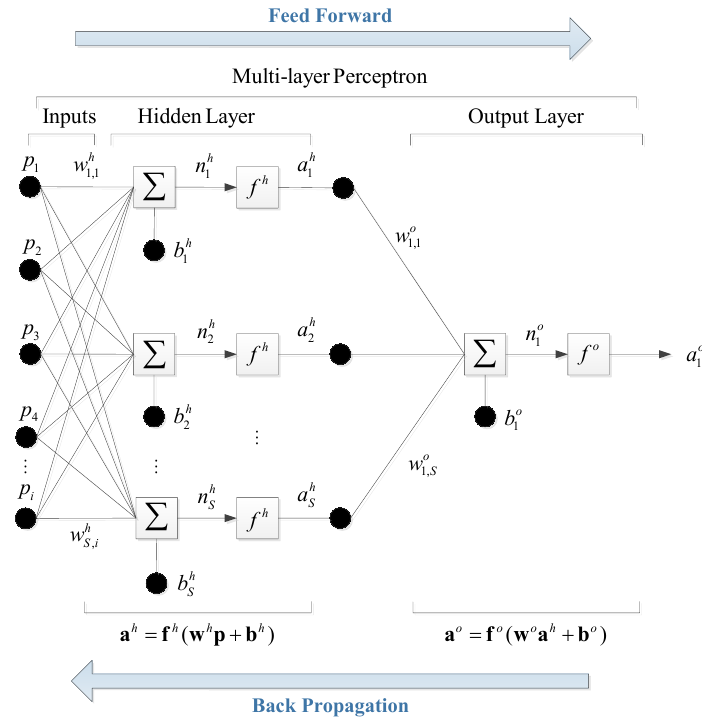
Figure 4. Network topography of ANN.